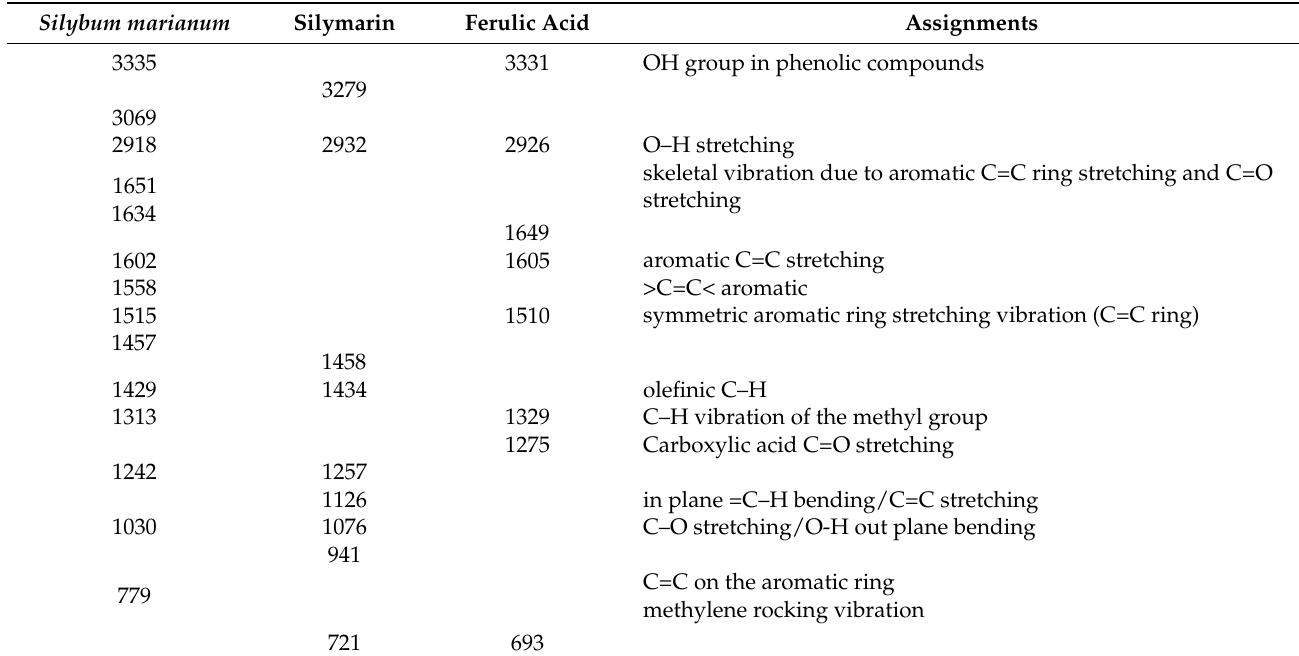
Table 2. Main bands in the FTIR spectra of S. marianum lyophilized hydromethanolic extract, silymarin and ferulic acid. Band positions are expressed in cm − 1 .